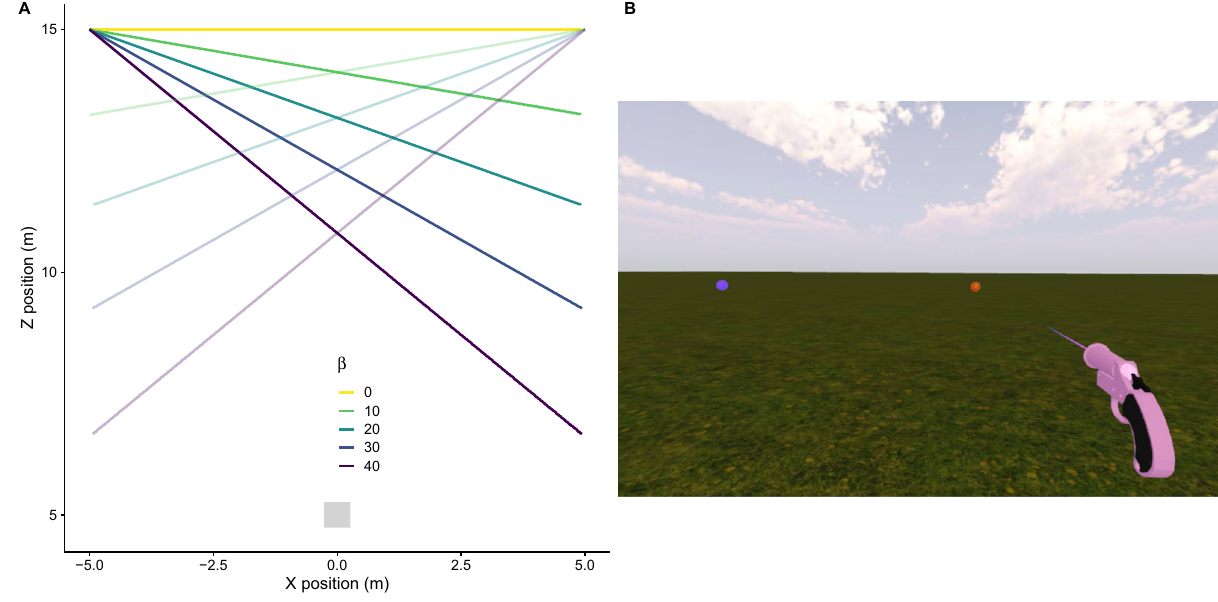
Figure 1. Trajectories in depth and illustration of the task. ( A ) Different possible trajectories described by the moving target. The starting position (x, z) of the target could be (− 5, 15) and then moved rightwards or (5, 15) and moved leftwards (trajectories with alpha transparency). The angle relative to the initial position of the participant (0, 5) could vary from 0° (yellow) to 40° (violet). ( B ) The moving target (red ball) approaches the interception or shooting location (violet) sphere; both target and shooting location have the same simulated physical size. The same grass texture was used in the two conditions (see